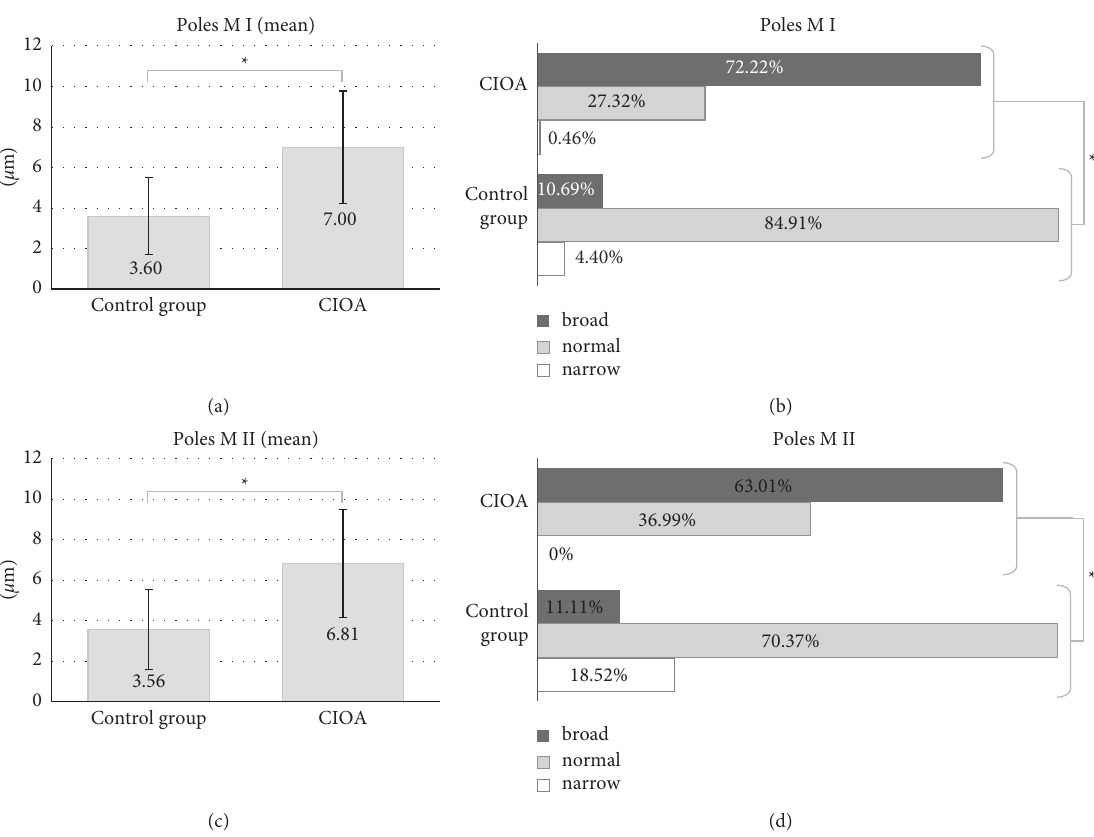
Figure 3: Spindle poles width. (a, b) data for M I and (c, d) data for M II. (a) M I mean pole width of the spindles. Spindle poles width (total mean ± 1 SD) of the control group (3.60 ± 1.90 μ m, n � 172) and CIOA (7.00 ± 2.78 μ m, n � 278); independent samples t -test, ∗ p < 0 . 001. (b) Distribution of M I pole width category frequencies in %. “Normal” range (mean ± 1 SD) from the control group. Control group ( n � 172): narrow ( n � 19), normal (3.60 ± 1.90 μ m, n � 135), and broad ( n � 18); CIOA ( n � 278): narrow ( n � 2), normal (3.60 ± 1.90 μ m, n � 75), and broad ( n � 201); Fisher–Freeman–Halton Exact Test, ∗ p < 0 . 001. (c) M II mean pole width of the spindles. Spindle poles width (total mean ± 1 SD) of the control group (3.56 ± 1.97 μ m, n � 232) and CIOA (6.81 ± 2.67 μ m, n � 102); independent samples t -test, ∗ p < 0 . 001. (d) Dis- tribution of M II pole width category frequencies in %. “Normal” range (mean ± 1 SD) from the control group. Control group ( n � 232): narrow ( n � 42), normal (3.56 ± 1.97 μ m, n � 150), and broad ( n � 40); CIOA ( n � 102): normal (3.56 ± 1.97 μ m, n � 38) and broad ( n � 64). Fisher–Freeman–Halton Exact Test, ∗ p < 0 .